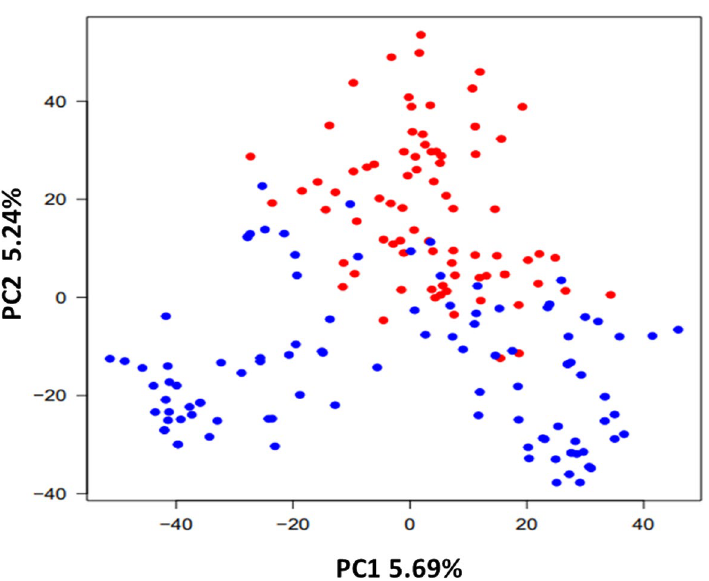
Figure 3. Principal component analysis (PCA) of 180 (100 spring and 80 winter) wheat accessions. The horizontal and vertical coordinates represent PC1 (with variance explained 5.69%) and PC2 (with variance explained 5.24%). Each dot represents a single accession. Spring and winter accessions are depicted by blue and red coloured dots